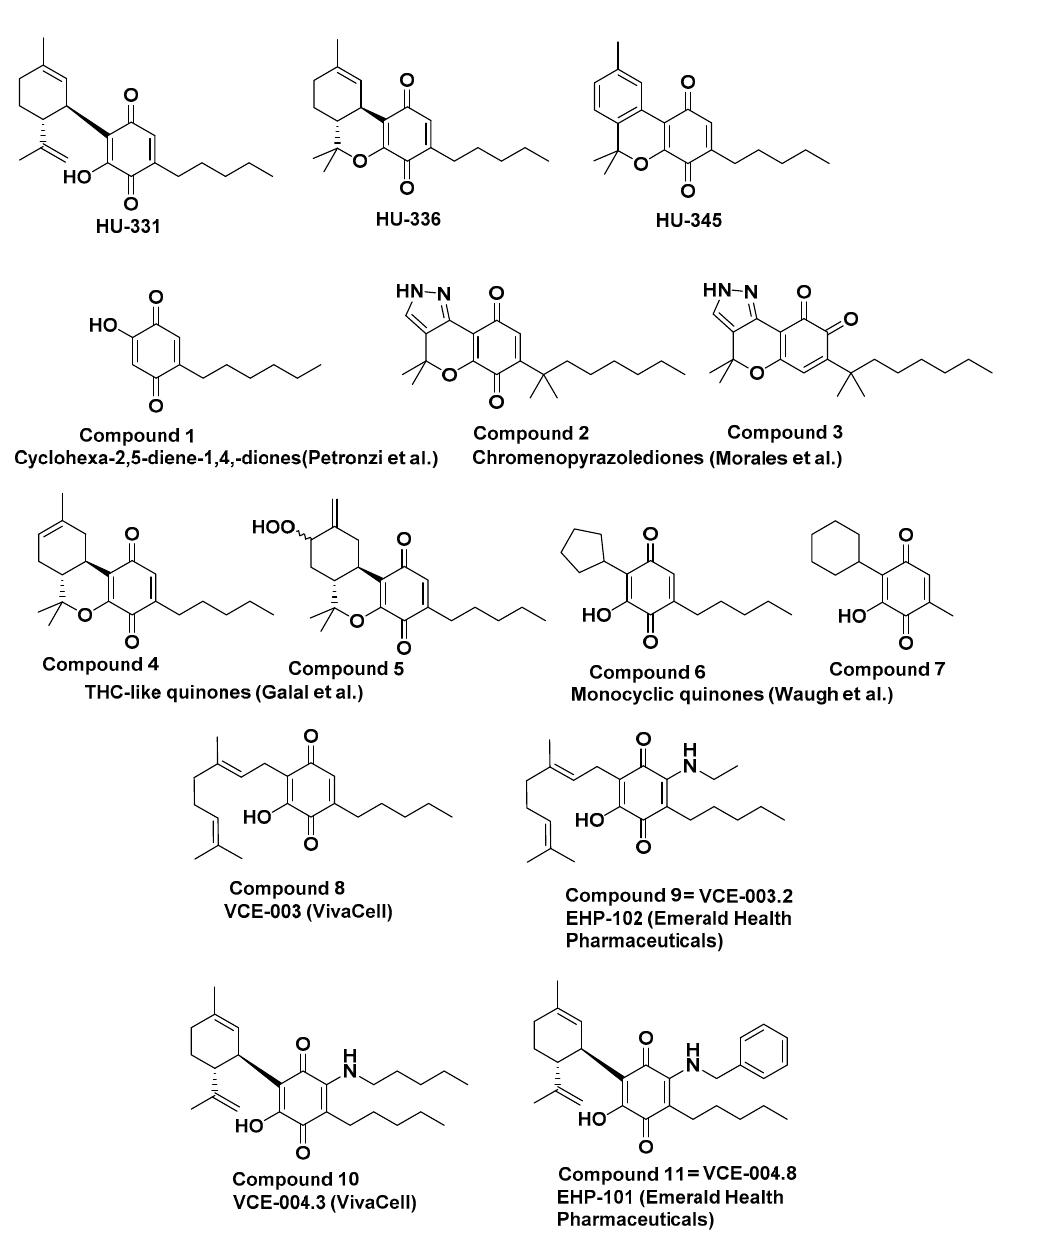
Figure 1. HU-331-like compounds.